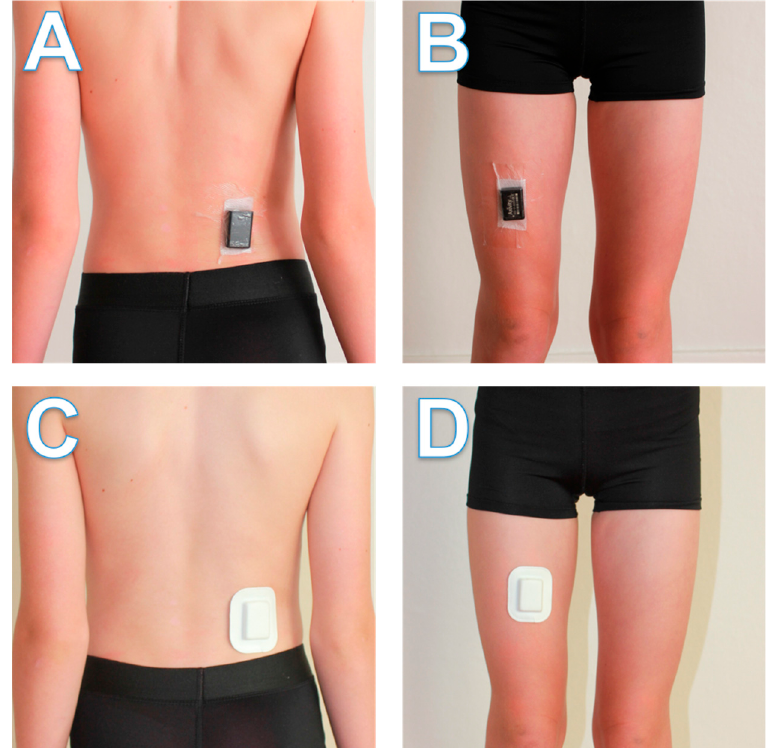
Figure 1. Attachment locations for the paired Axivity AX3 accelerometers. ( A ) Back sensor fastened with medical dressing; ( B ) Thigh sensor fastened with medical dressing; ( C ) Back sensor fastened with foam pouch; ( D ) Thigh sensor fastened with foam pouch.